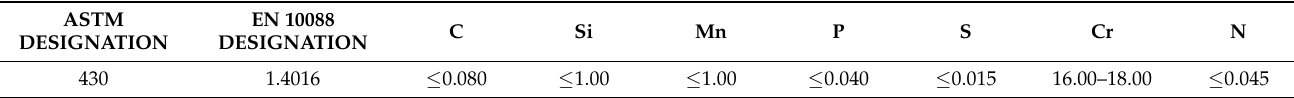
Table 1. Chemical composition of the AISI 430 ferritic stainless steel samples under